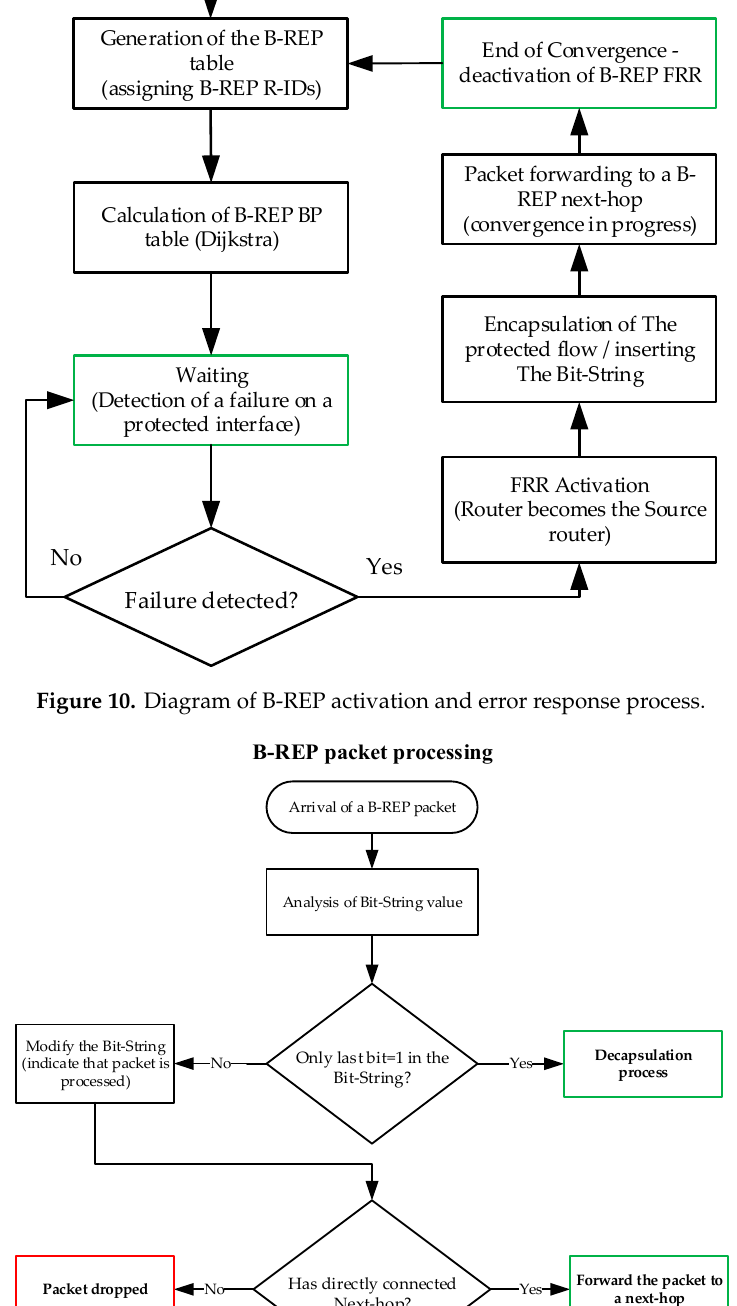
Figure 11. Processing of B-REP packet.